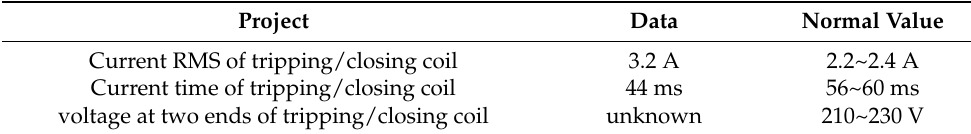
Table 6. Abnormal data and unknown data of CB4.